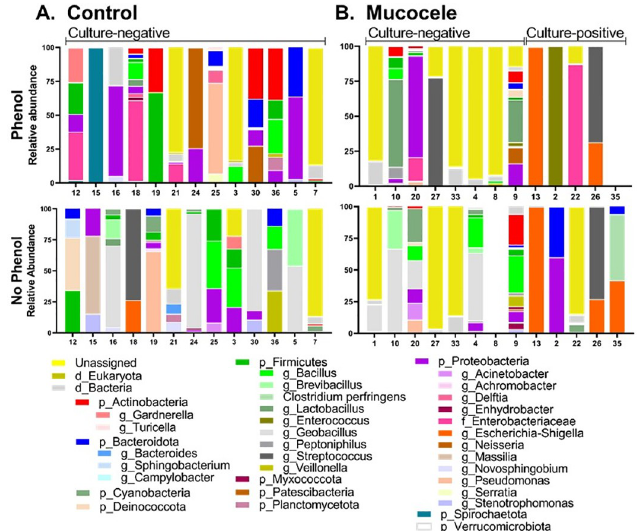
Fig 3. Percent abundance of phyla amplified from the bile of 13 apparently healthy adult dogs (panel A) and gallbladder mucus from 13 dogs with mucocele formation (panel B). Data were filtered for contaminating sequences and taxa with read counts � 10 in all samples. For each sample, abundance data are shown for sequencing results obtained using each of two different extraction methods (phenol and